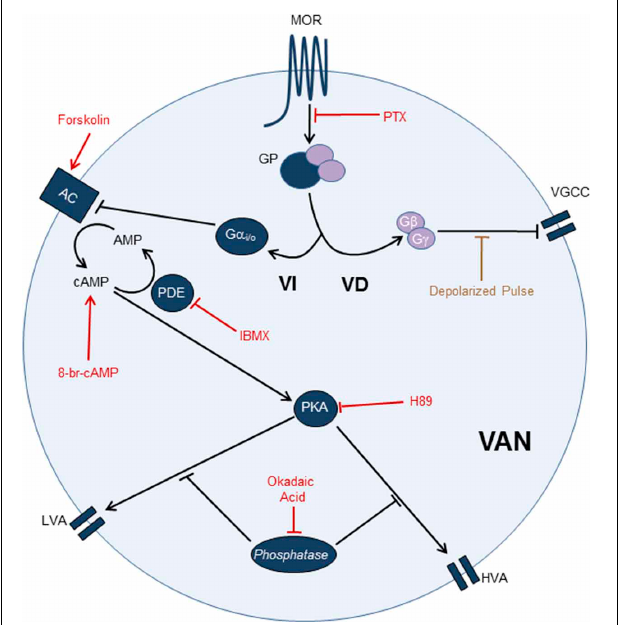
FIGURE 10 | MOR activation pathway leading to I Ca inhibition in the VANs. The use of PTX showed that the I Ca inhibition by MOR activation is G α i / o dependent. Use of paired pulses showed that the VD signaling mechanism does not significantly participate in the I Ca inhibition. The use of forskolin, 8-Br-cAMP, IBMX, H89, and okadaic acid indicate that the I Ca inhibition (LVA and HVA) by MOR activation is mediated by the cAMP pathway. Involving the G α i / o inhibition, AC inhibition, decreased of cAMP levels, decreased of PKA activity and decreased of PKA-dependent phosphorylation of calcium channels. In the scheme, arrow-endings indicate activation and the line-endings indicate inhibition. The names and lines in red indicate the drugs used. AC, Adenylyl cyclase; GP, G Protein; PDE, Phosphodiesterase; VD, Voltage dependent signaling mechanism; VGCC, Voltage gated calcium channels; VI, Voltage independent signaling